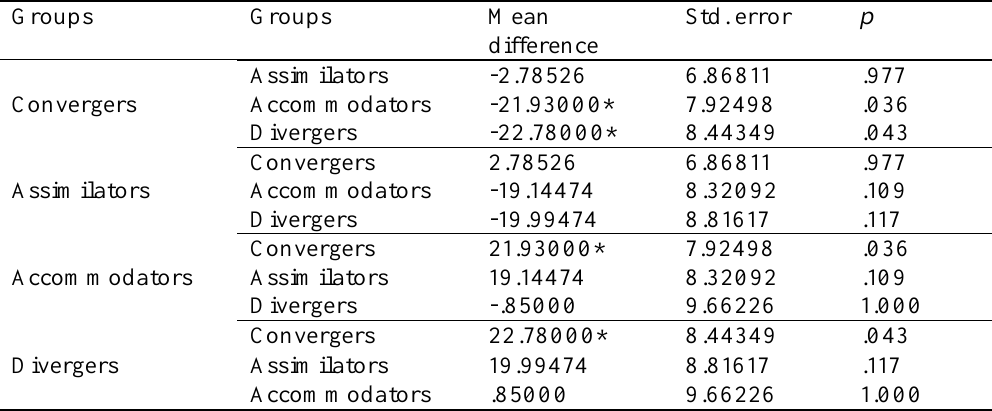
Tukey HSD Test Results among Four Learning Style